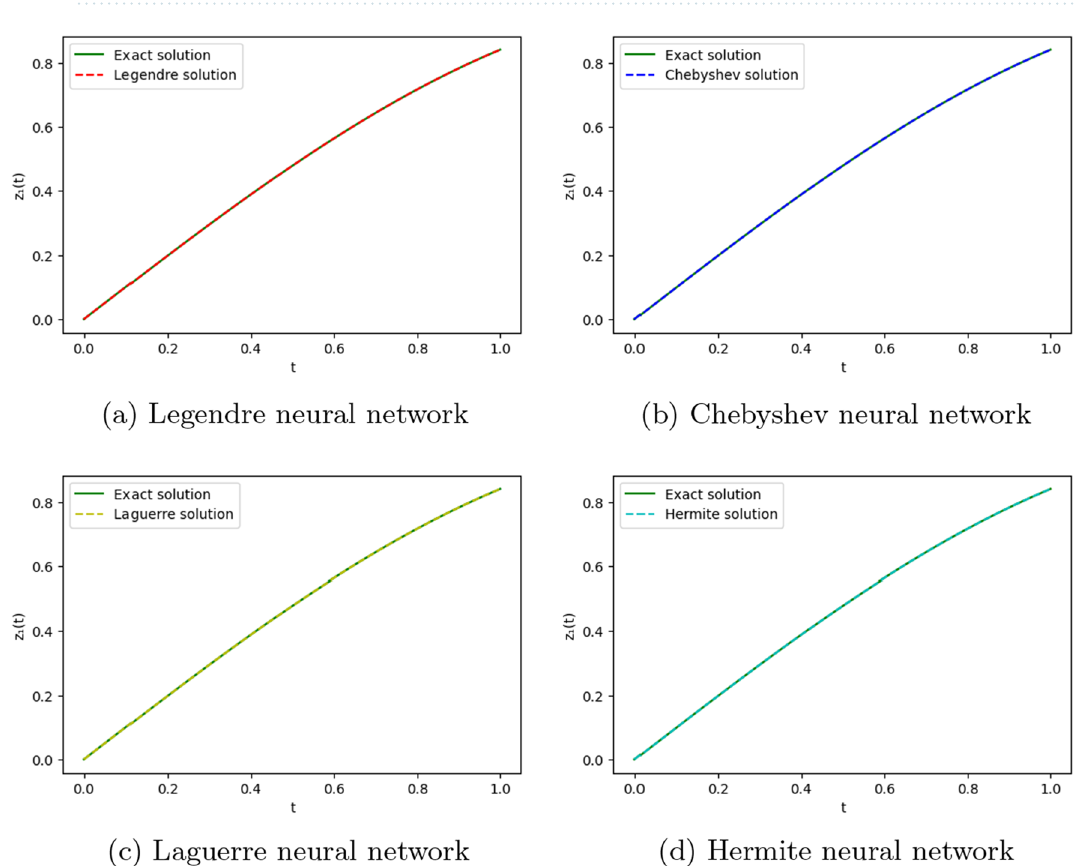
Figure 17. Comparison of the exact solution z 1 ( t ) with the obtained approximate solutions of Example